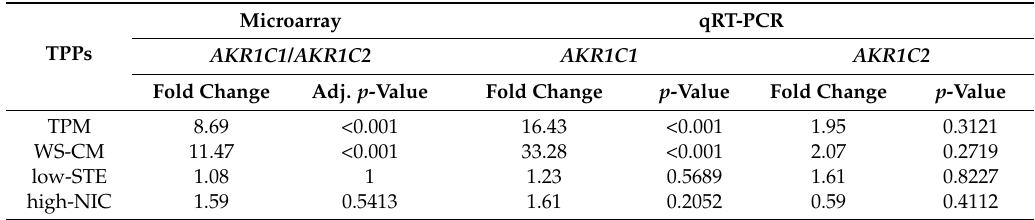
Table 4. Microarray results and real time qRT-PCR results with Student’s t -test p -value for AKR1C1 and AKR1C2 mRNA level in